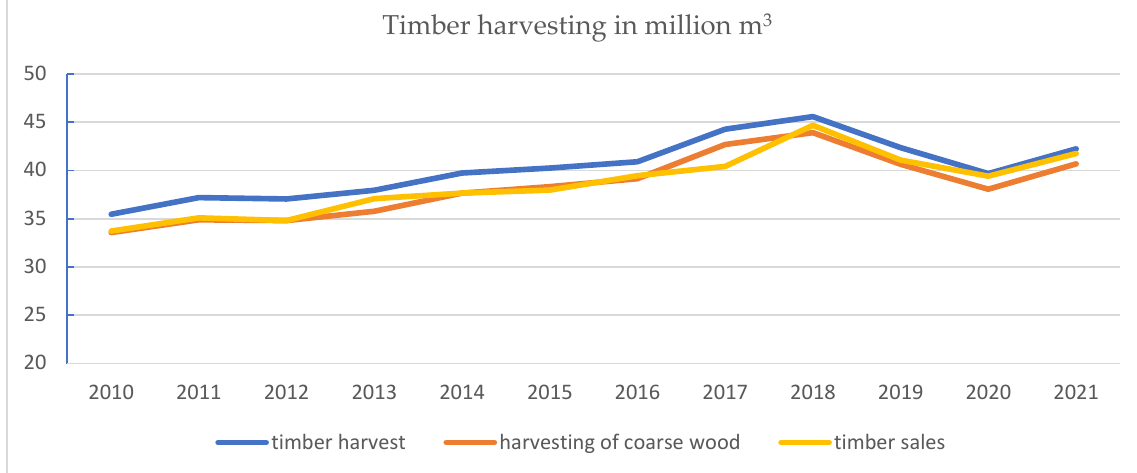
wood biomass was indicated.